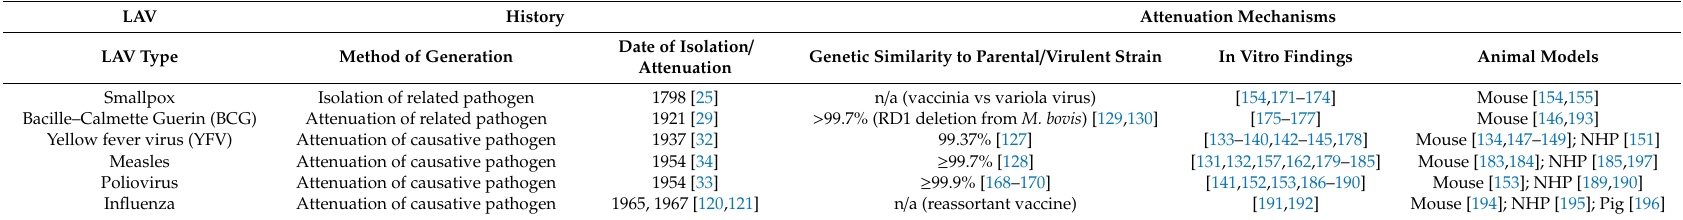
Table 2. LAV history and non-exhaustive list of attenuation